Question: Briefly state, in one sentence, what is plotted here.
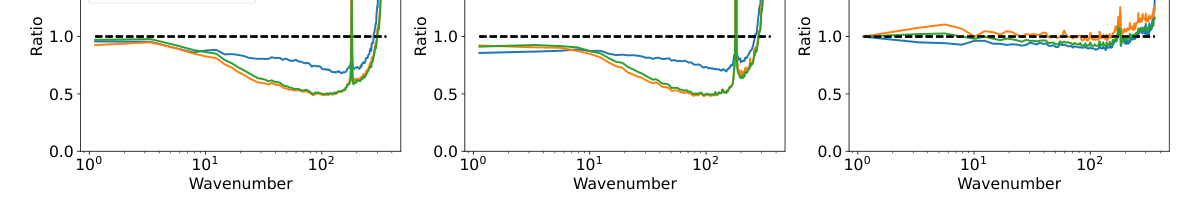
Answer: Spatial frequency representation for the z500, t2m, and u10m variables across three model configurations: the baseline model using channel-weighting, and two fine-tuned versions of that model using 4-step and 8-step fine-tuning respectively. For each variable and model, the upper plot shows the power spectral density (PS1D) of both the target ERA5 (black line) and prediction (red line) on a logarithmic scale. The lower plot displays the ratio of predicted to actual PS1D values, with a ratio of 1 (dashed line) indicating perfect alignment. Ratios above or below 1 indicate overestimations or underestimations of power at specific spatial frequencies, respectively.